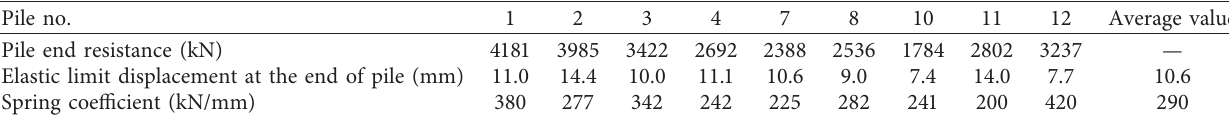
Table 8: Values of parameters achieved from the results of HSDT (at the hard rock bearing stratum site). Pile no.